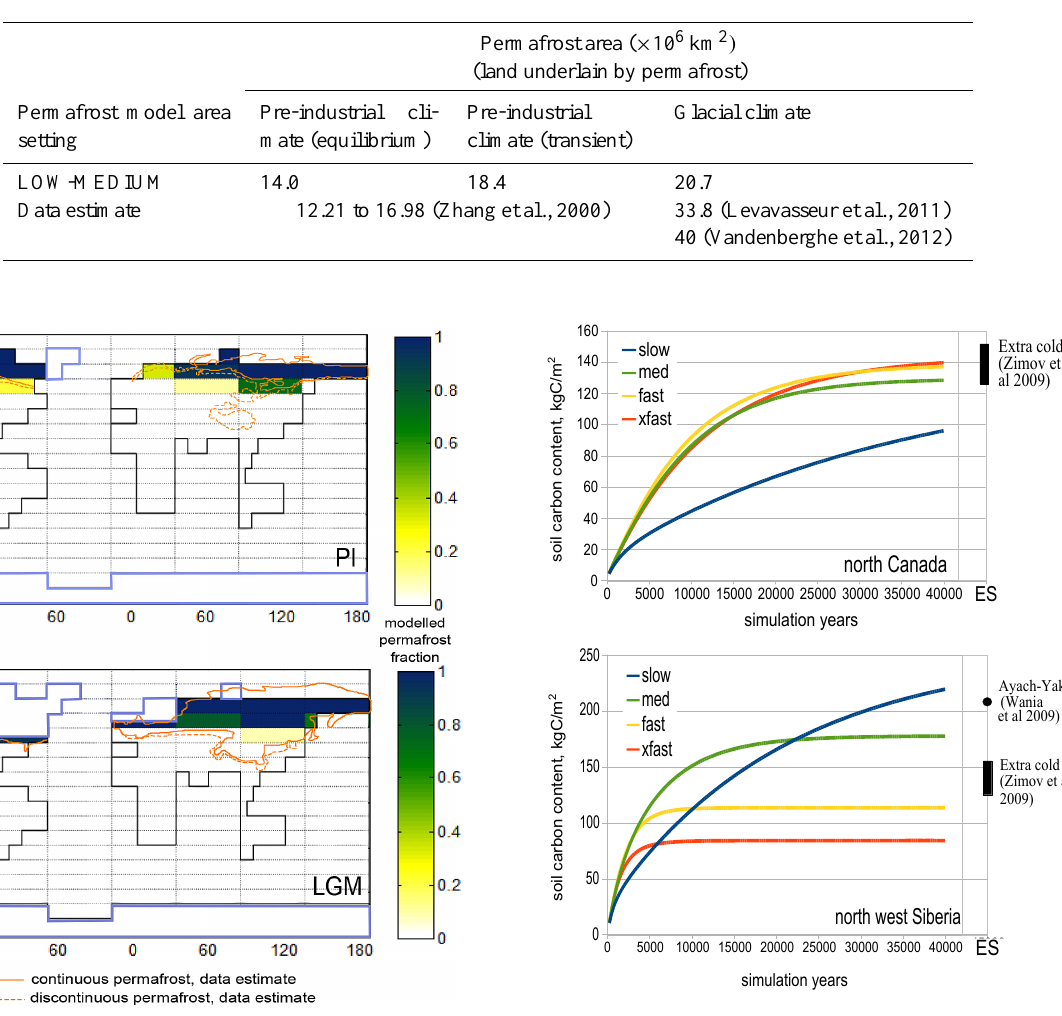
Figure 15. Modelled PI(eq) simulation output for total soil column carbon content for two grid cells. ES is equilibrium state ( >